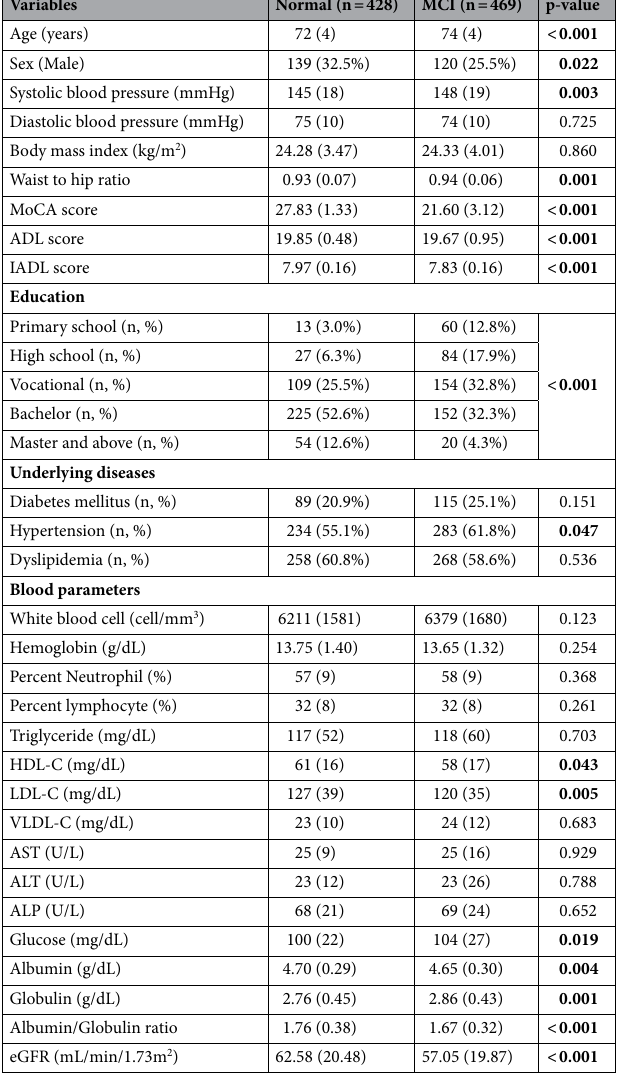
Table 1. Demographic data of participants. Continuous variables are presented as mean (standard deviation) and are compared between normal and MCI participants by Student’s t-test. Categorical variable is presented as number with percent and are compared by the chi-square test. Bold values represent a statistical significance. ADL activities of daily living, ALP alkaline phosphatase, ALT alanine aminotransferase, AST aspartate aminotransferase, eGFR estimated glomerular filtration rate, HDL-C High-density lipoprotein cholesterol, IADL instrumental activities of daily living, LDL-C Low-density lipoprotein cholesterol, MoCA Montreal cognitive assessment, VLDL-C Very low-density lipoprotein